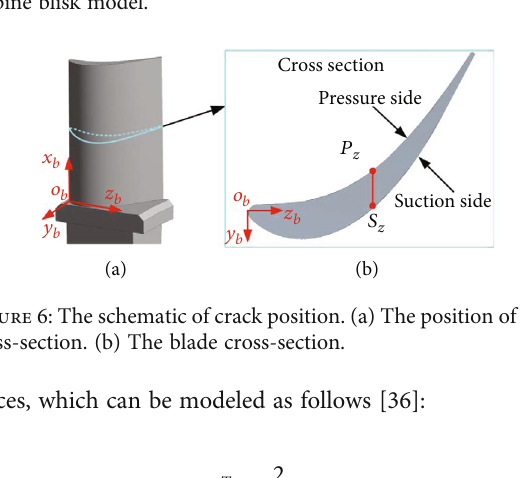
and β . (a) Schematic 0 0